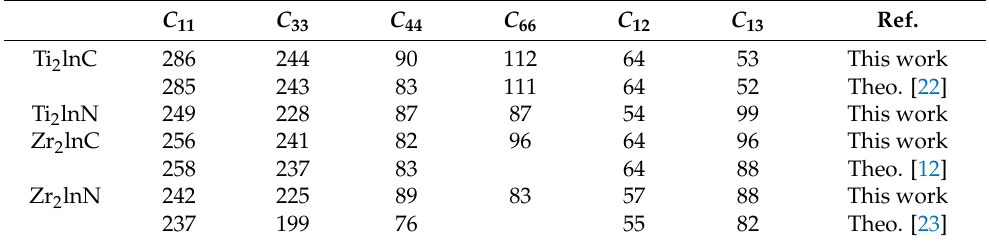
Table 2. The elastic constants C ij (in GPa) of M 2 InX (M = Ti, Zr and X = C, N) MAX phases.